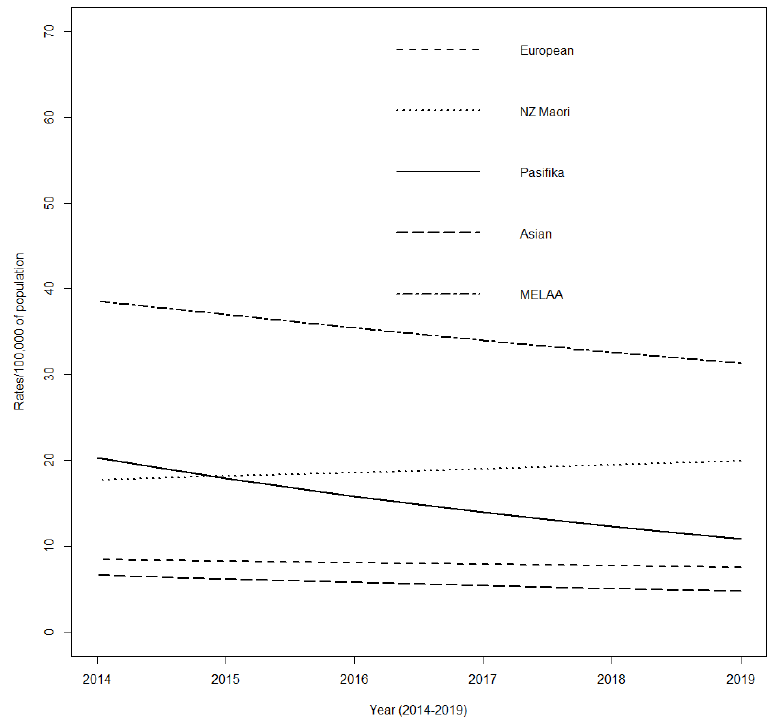
Figure 1. Incidence rates of total hospital admissions for children and young adults with cerebral palsy by ethnicity, Aotearoa New Zealand; 2014–2019. Table 4. Univariate analysis and odds ratio analysis for ≥ 2 antibiotic episodes per year for gender, GMFCS, ethnicity, and NZDep